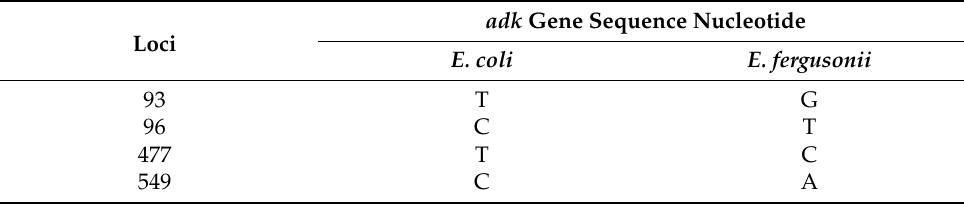
Table 1. Differentiating adk gene nucleotides of E. coli against E. fergusonii strains. adk Gene Sequence Nucleotide Loci E. coli